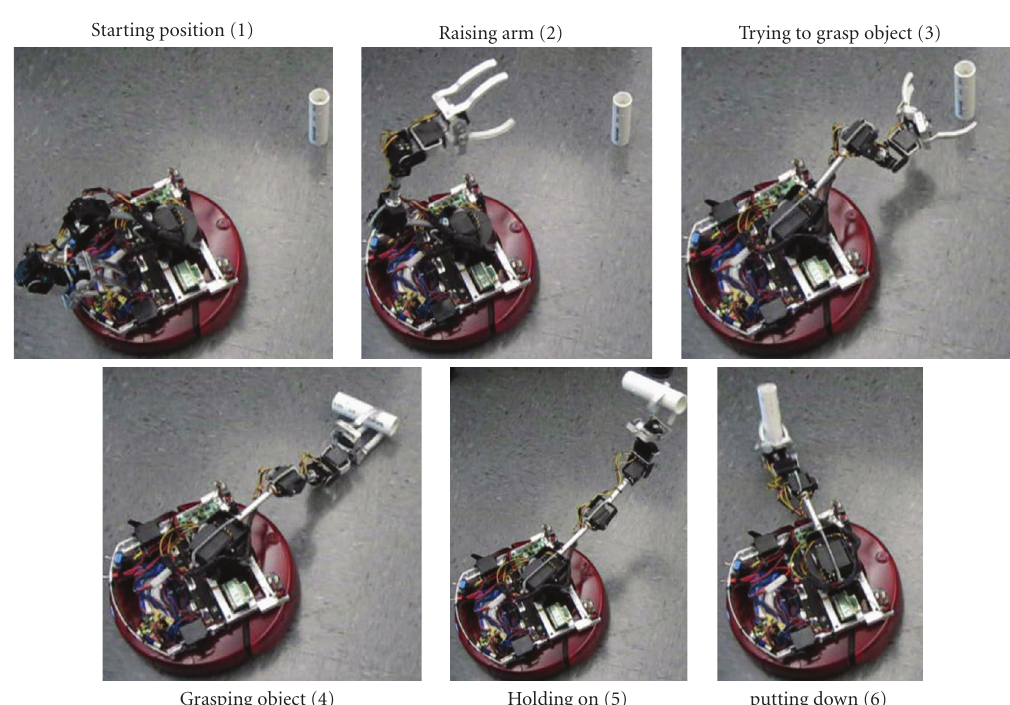
Figure 16: Screen shots of the robot arm grasping